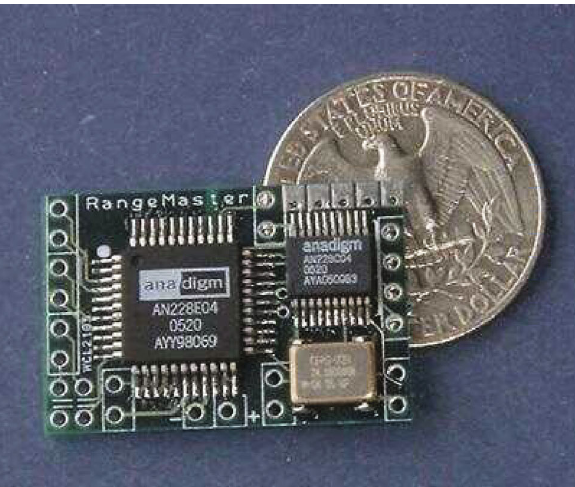
Figure 10: Anadigm FPAA evaluation